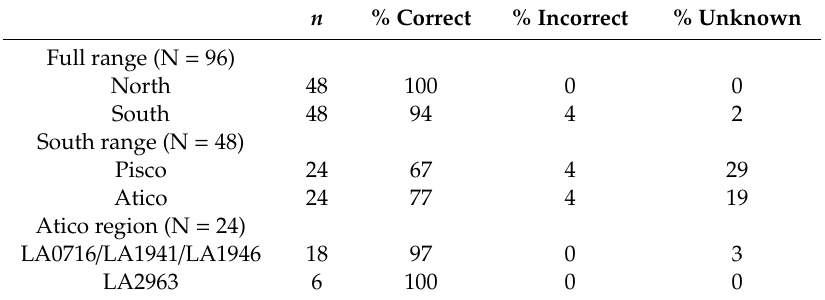
Table4. Orthogonalpartialleastsquares / projectiontolatentstructuresdiscriminantanalysis(OPLS–DA) model performance. The table indicates the percentage of test samples that each model classified correctly, incorrectly, or was unable to classify. n % Correct % Incorrect %